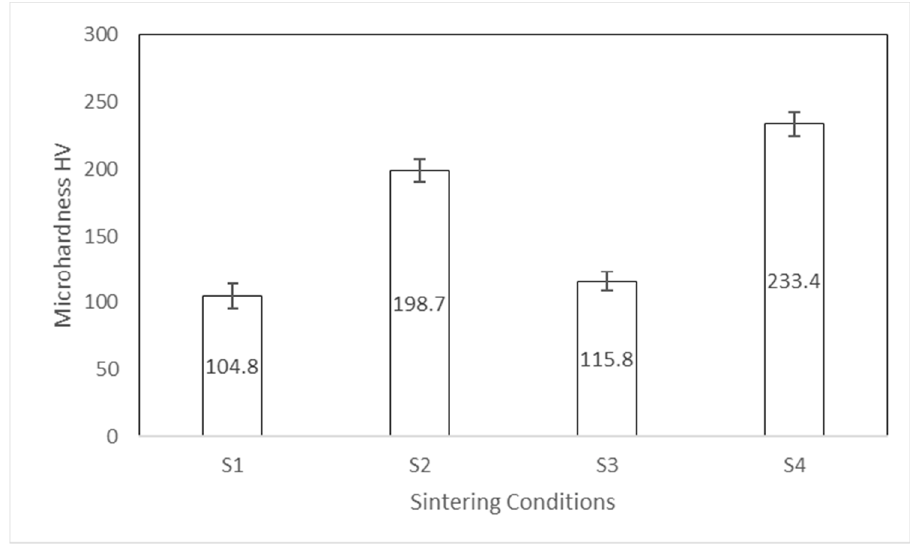
Figure 10. Micro-hardness tests of as sintered NiMnFeCu under various sintering conditions.